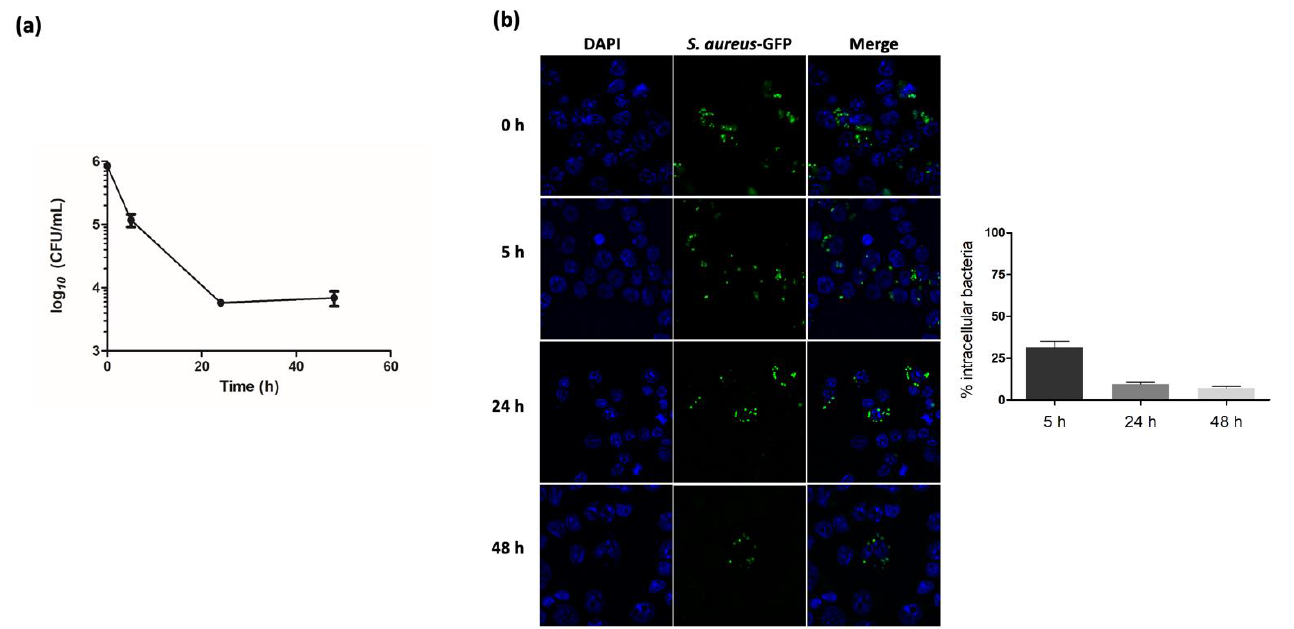
Figure 1. S. aureus strain NSA739 persists intracellularly in Raw264.7 macrophages up to 48 h post-gentamicin treatment (pGt). ( a ) Macrophages were infected with S. aureus NSA739 strain expressing the GFP protein at an MOI of 10 for 1 h, and the number of gentamicin-protected bacteria was determined at different time points by plating intracellular bacteria for CFU enumeration. ( b ) Representative images of fluorescence microscopy of GFP-labeled S. aureus NSA739. Macrophages seeded on coverslips were infected with GFP-labeled bacteria at a MOI of 10 and analyzed at 5, 24, and 48 h pGt using a 63-oil objective. Quantification was performed using intracellular bacteria at T0 pGt as 100% and is the result of independent counting of 100 cells from each of three independent experiments. n.i, non-infected control cells.